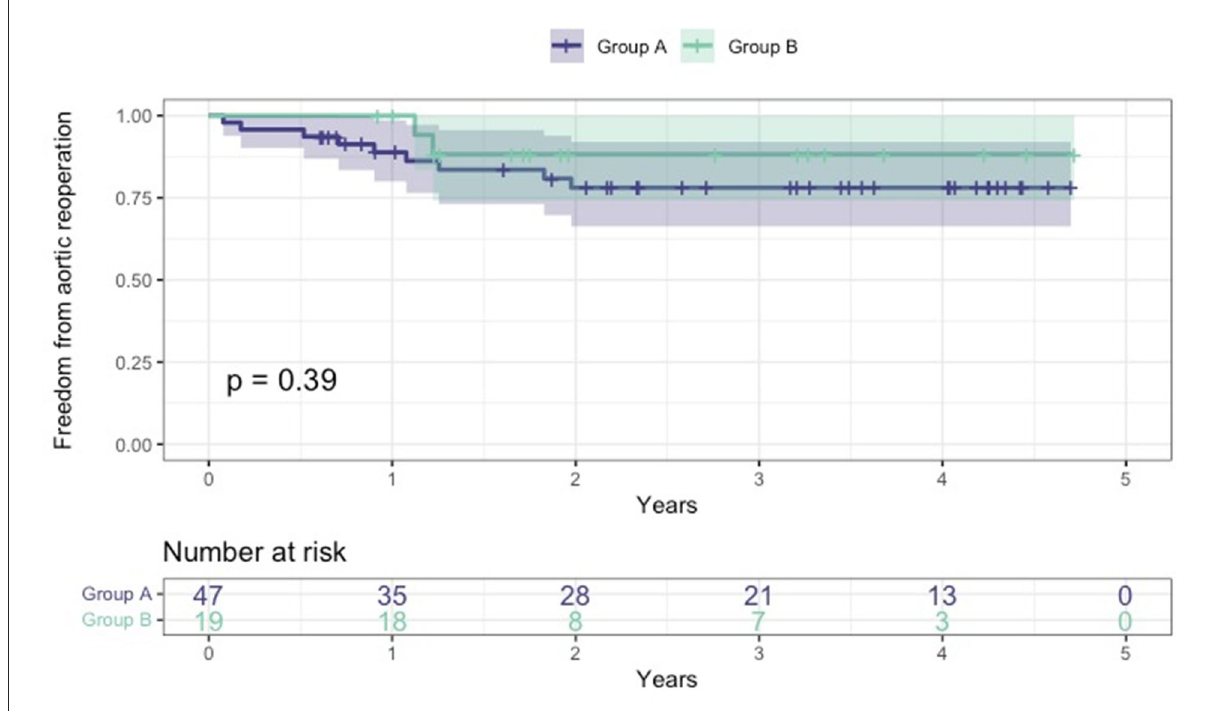
FIGURE5 Kaplan-Meier freedom from aortic reoperation curves between the two groups. Group A: age at surgery < 70 years; group B: age at surgery ≥